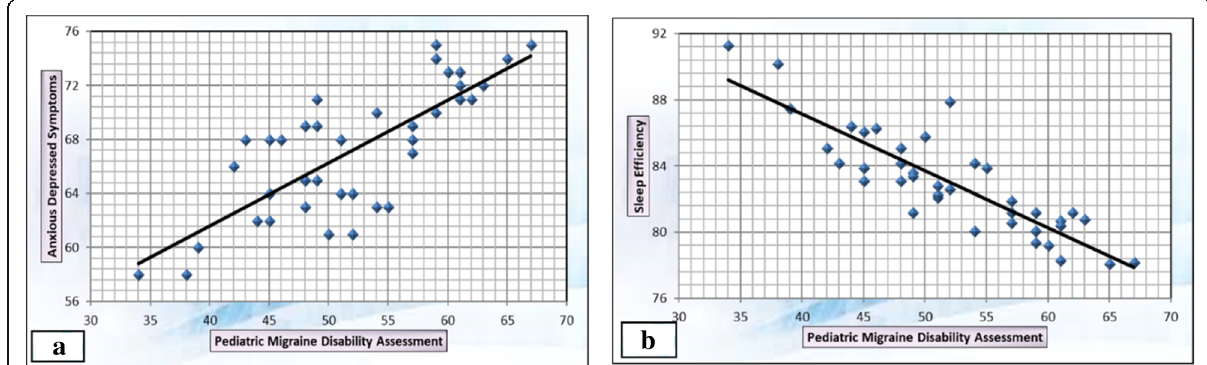
Fig. 1 a Positive correlation between PedMIDAS and anxious/depressed symptoms. b Negative correlation between PedMEDAS and sleep efficiency. PedMIDAS pediatric migraine disability assessment scale